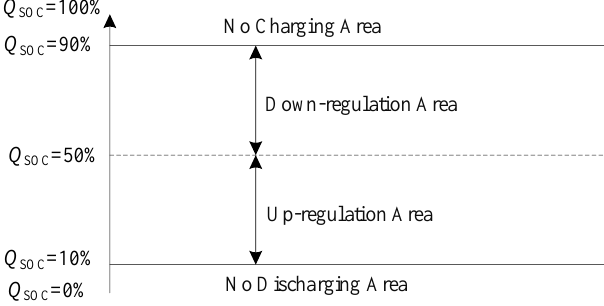
Figure 3. Schematic diagram of up- and down-regulation of energy storage unit.